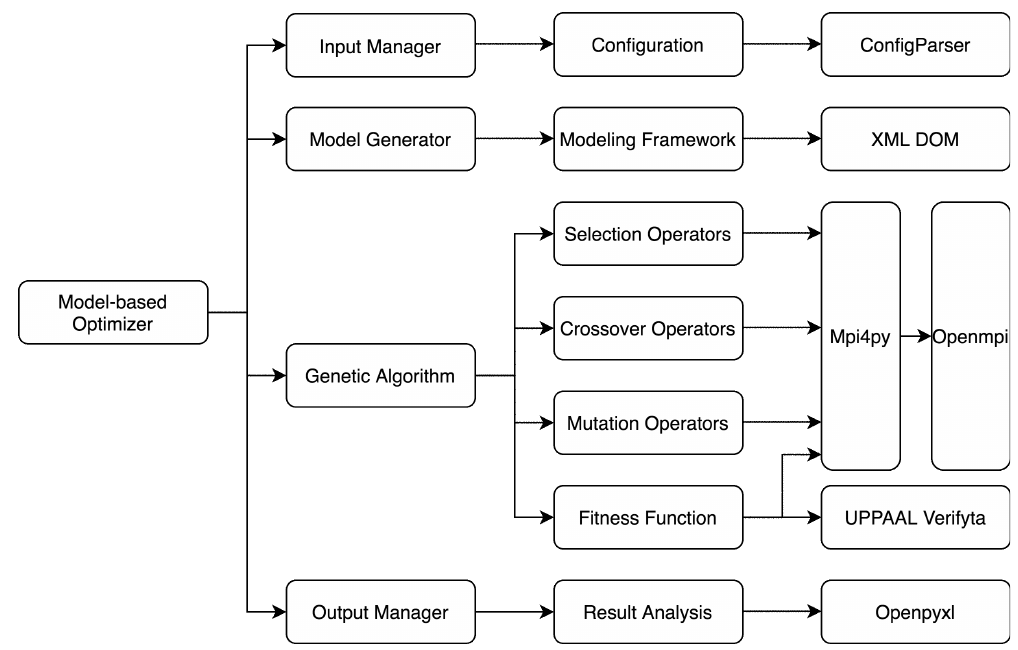
Figure 9. Hierarchical structure of the model-based optimizer.